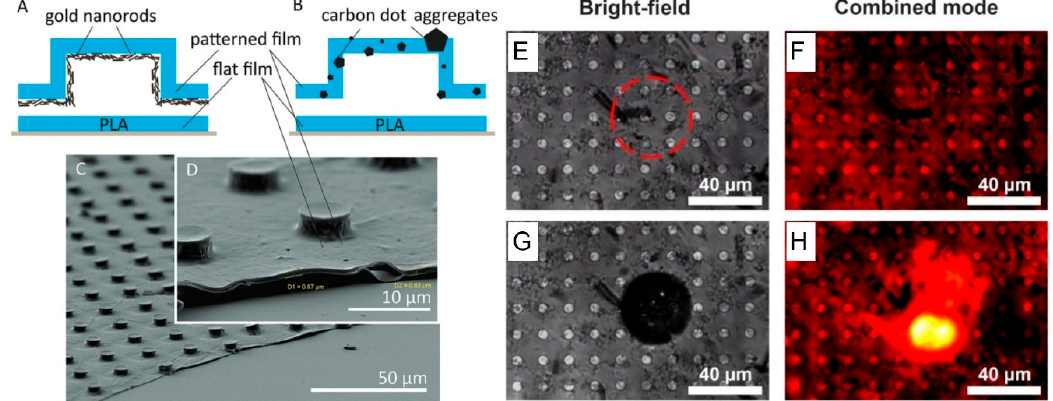
Figure 4. Left: Scheme of the gold nanorods ( A ) and carbon nanoparticles ( B ) location in the polylactic microchamber array. Typical SEM images of a polylactic microchamber array with gold nanorods ( C ) and carbon nanoparticles ( D ) (Reprinted with permission from Reference [11], Copyright (2018) The Royal Society of Chemistry); Right: Increased fluorescence of Nile Red dye after the release of hydrogen peroxide due to oxidation process in bright field ( E , G ) and combined mode ( F , H ) (Reprinted with permission from Reference [51], Copyright (2020) The Royal Society of Chemistry).